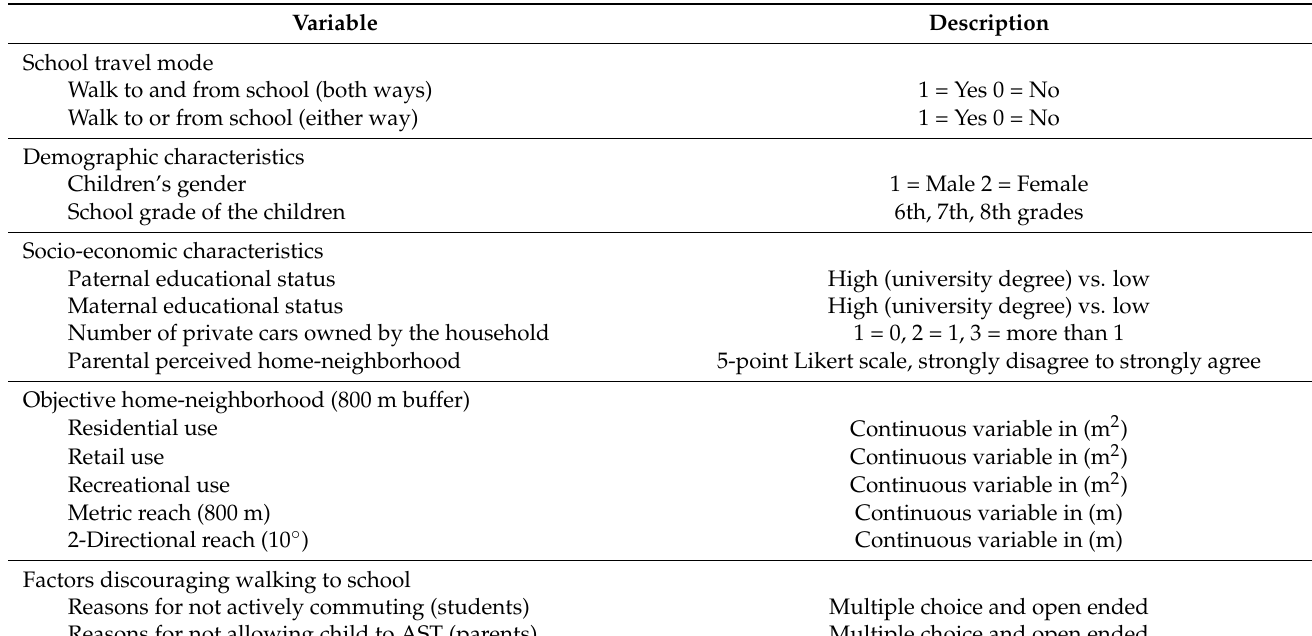
Table 1. Description of variables used in the